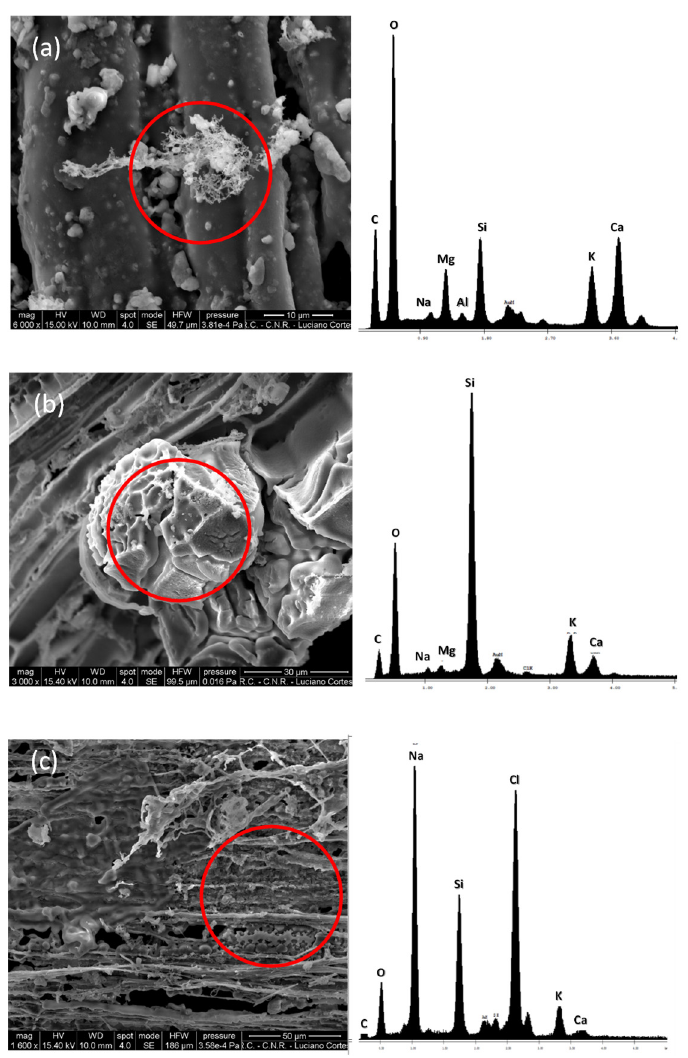
Figure 19. SEM-EDX analysis of the samples deposited on the ground at the Naples NF on 17 July 2017.